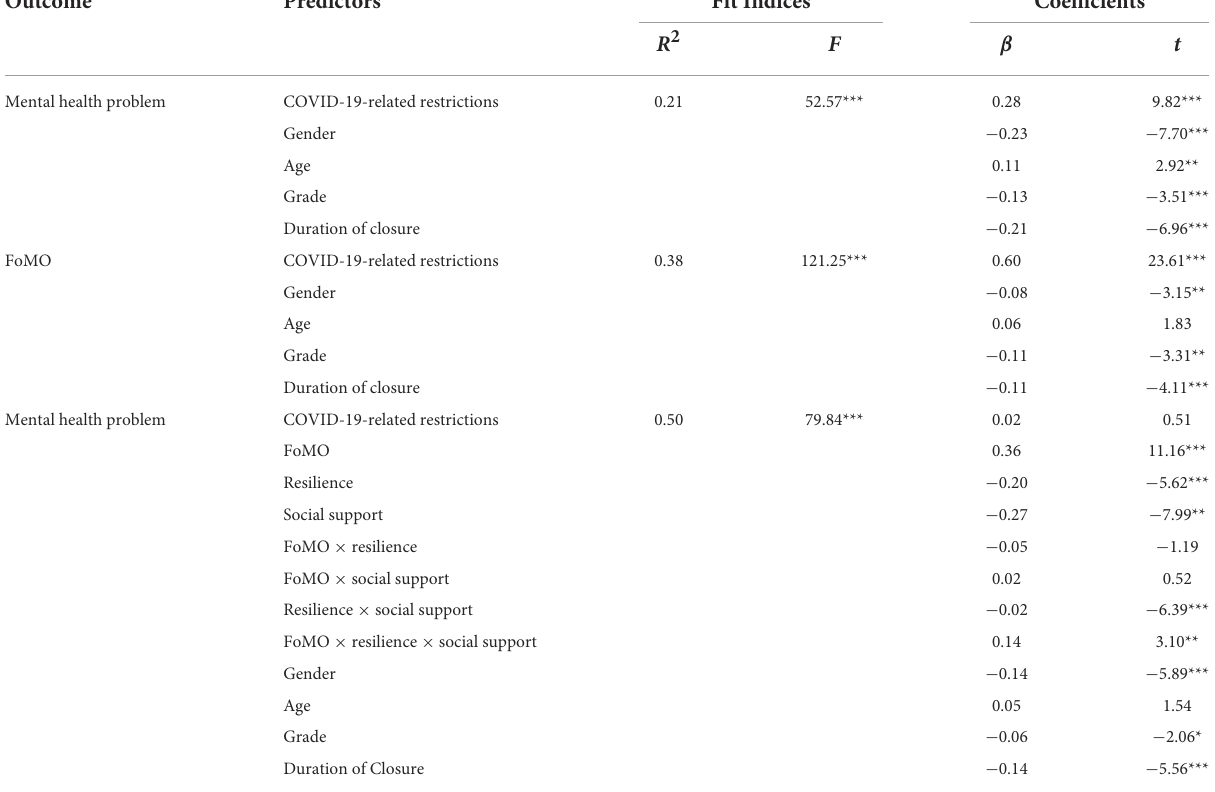
TABLE 4 The moderated moderated mediating tests of mental health